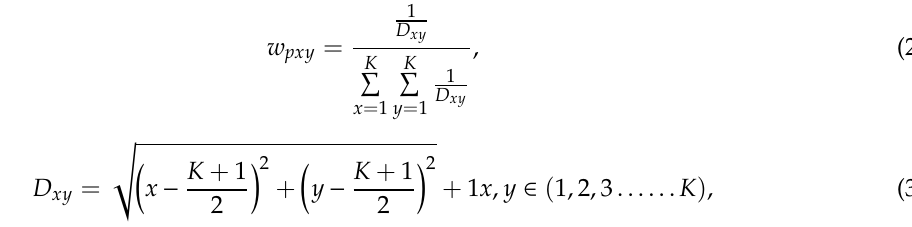
of pixel P ij (K = pij n P O of pixel ij (K = 5). pij